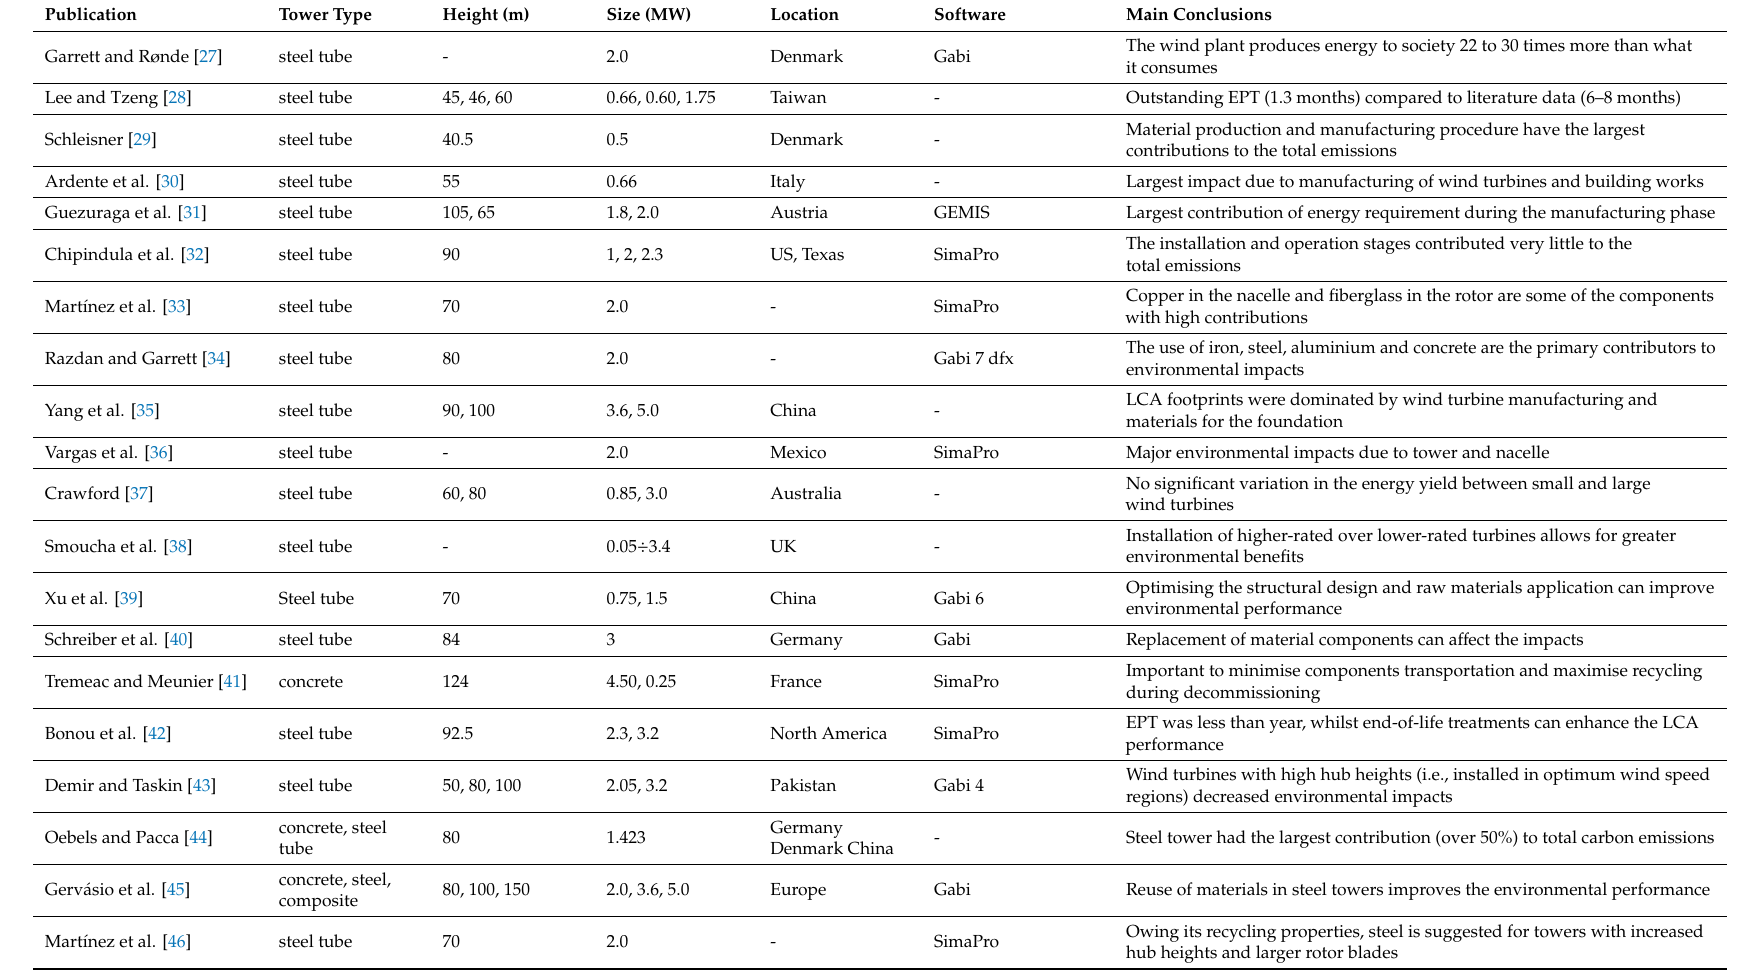
Table 1. Past studies on LCA of onshore wind turbine